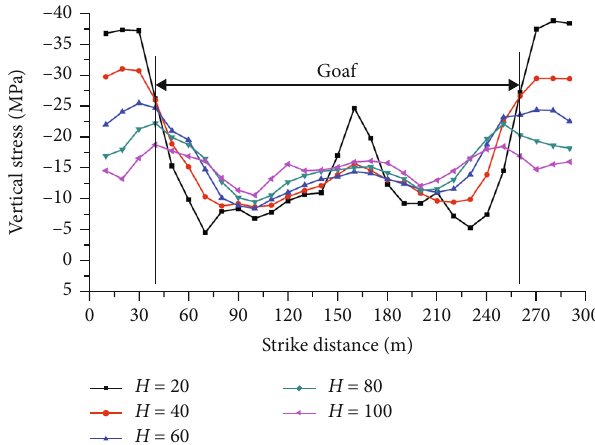
Figure 13: Stress evolution curves of bedrock in di ff erent positions above coal seam.